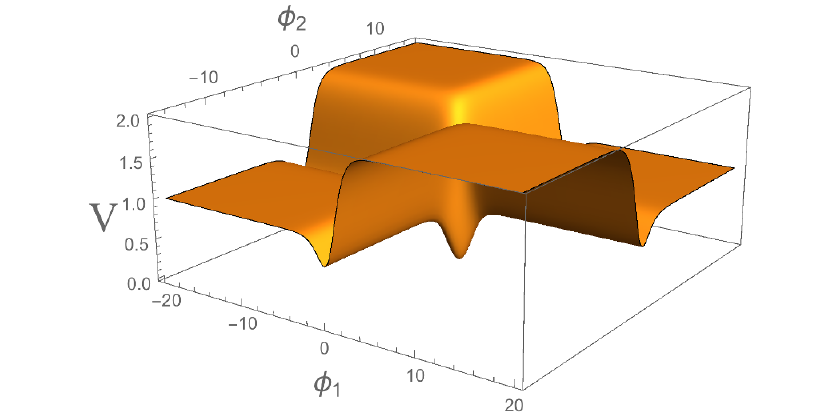
Figure 6 . The potential of the two disks with (cid:11) = 1 = 3 for m = M .